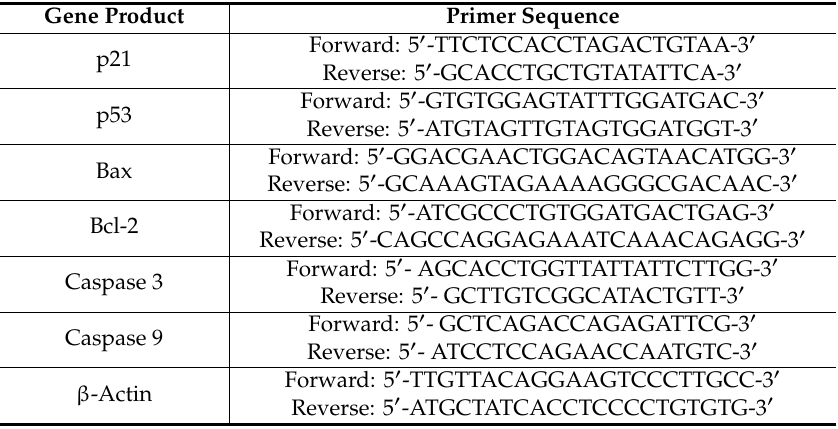
Table 1. Oligonucleotide primers used for Real-Time